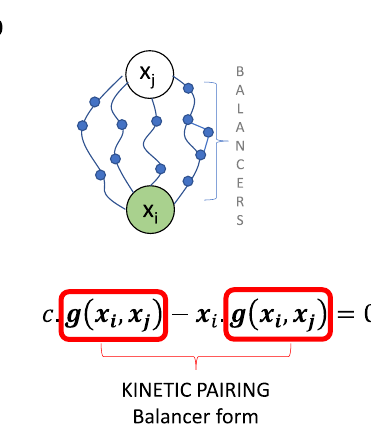
Fig. 4 | The principle of Kinetic Pairing and its topological consequences. a An Opposer module has a feedback structure, and contains either a single opposer node (not shown) or an organized collection of opposer nodes (known as an ‘ opposing set ’ , as shown), embedded into the feedback segment of the circuit. Opposernodesare indicatedinyellow. The regulatorof this feedback segment, x i , isthesensormoleculeforthecontrollednetwork,andthusregulates x j (directly,or indirectly). RPA is achieved at x i when the upregulating and dowregulating